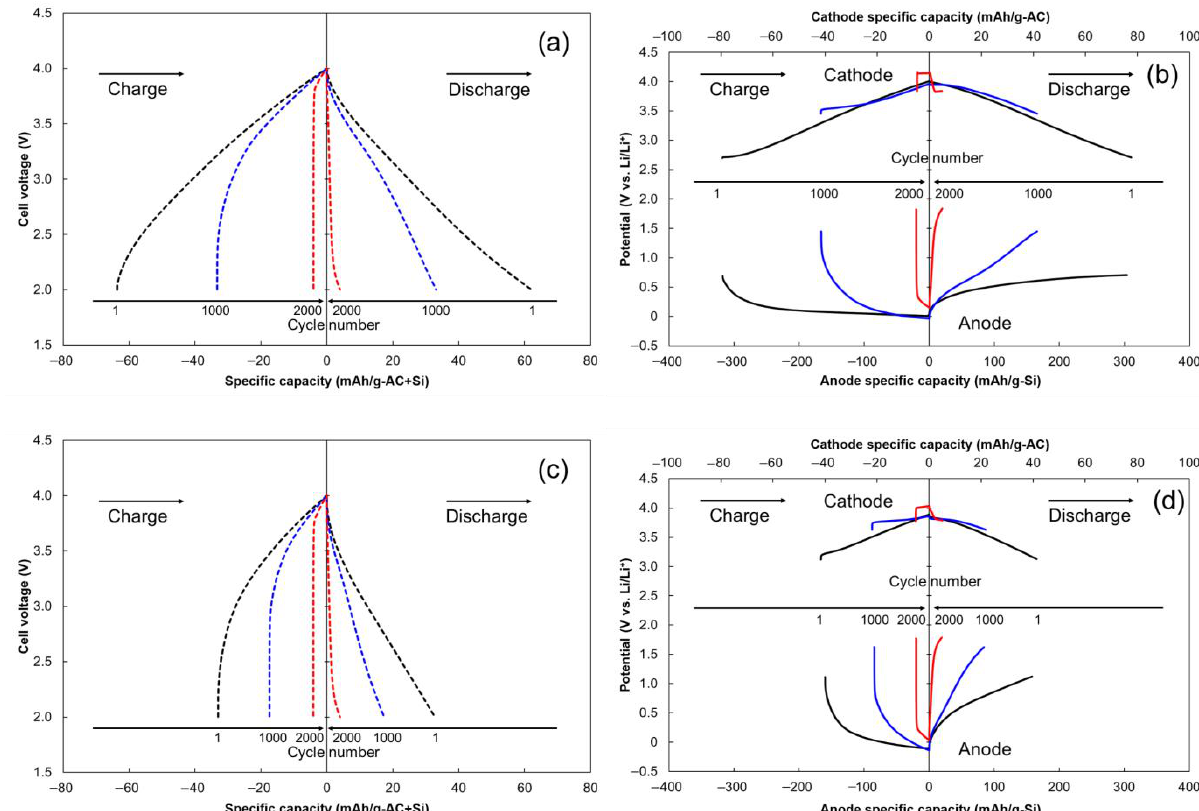
Figure 5. Variations in cell voltages and in cathode and anode potentials of the Si-based LICs during the cycle test at a constant current density of 1.0 mA/cm 2 . ( a ) Cell voltage–specific capacity profile of the 100% prelithiation cell, ( b ) potential variations in the cathode and anode of the 100% prelithiation cell, ( c ) cell voltage–specific capacity profile of the 87% prelithiation cell, and ( d ) potential variations in the cathode and anode of the 87% prelithiation cell.